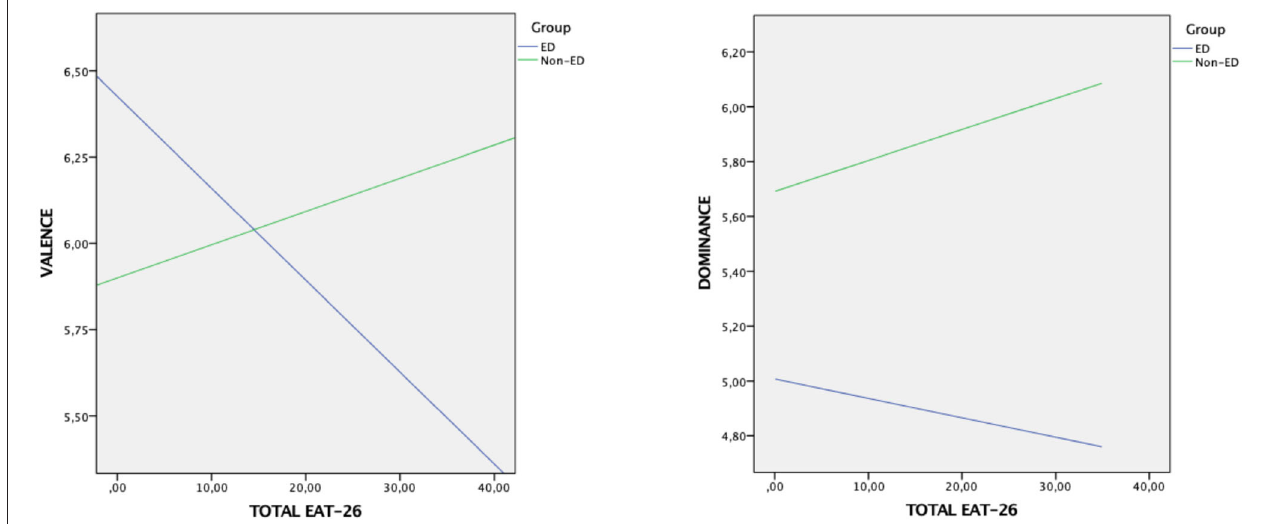
FIGURE 2 | Interaction effect of the moderator variable group on the emotional processing of food images (Valence, Dominance) according to the EAT-26 score.